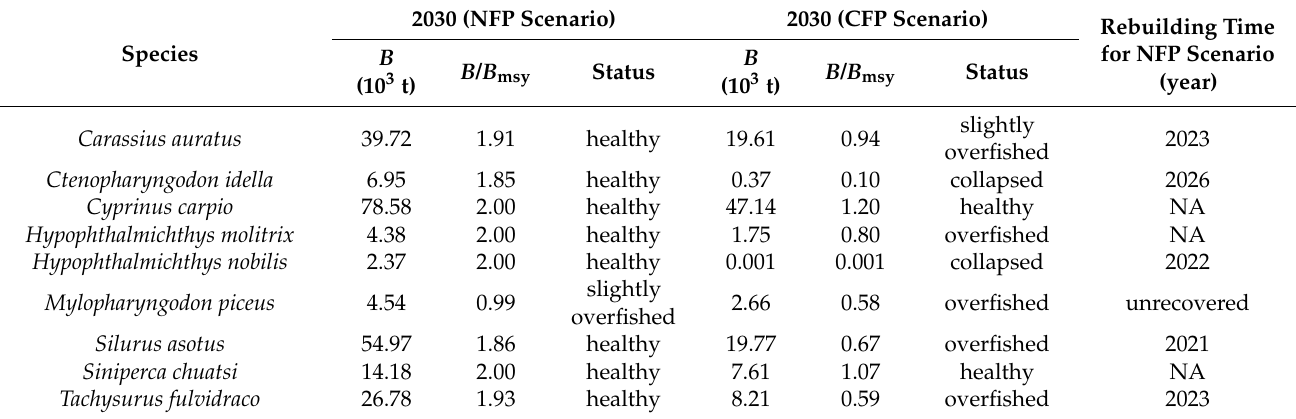
Table 2. Stocks rebuilding of nine main fishes in 2030 based on two different scenarios. NFP and CFP represent non-fishing pressure and current fishing pressure scenarios, respectively. Reference points B and B msy indicate biomass and biomass capable of producing MSY, respectively. Categories of stock status are: B / B msy > 1.0, healthy; 0.8 < B / B msy ≤ 1.0, slightly overfished; 0.5 < B / B msy ≤